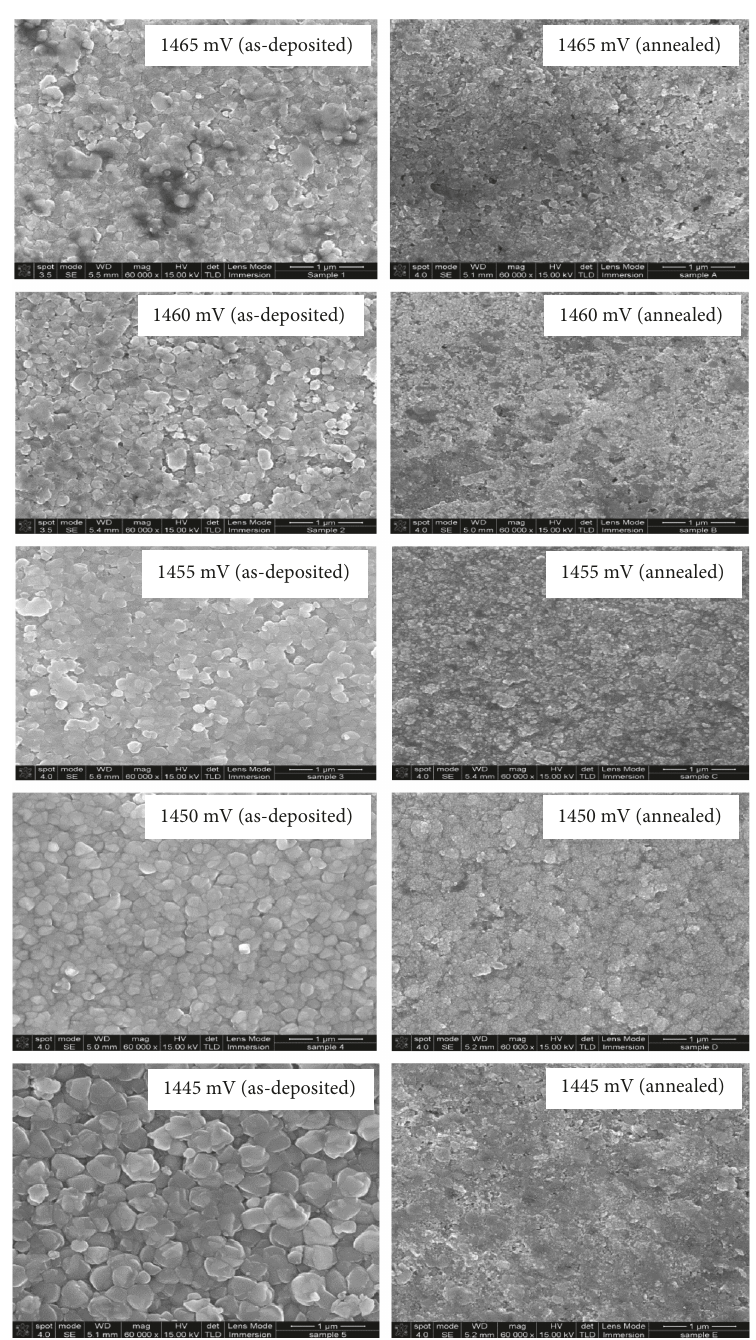
Figure 5: SEM images of as-deposited and annealed CdS samples grown at di ff erent cathodic voltages for 45 minutes. CdCl done with saturated CdCl in 2